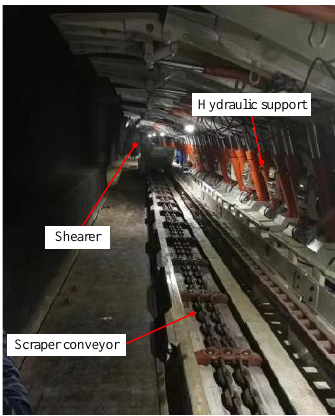
Figure 1. Scraper Conveyor.